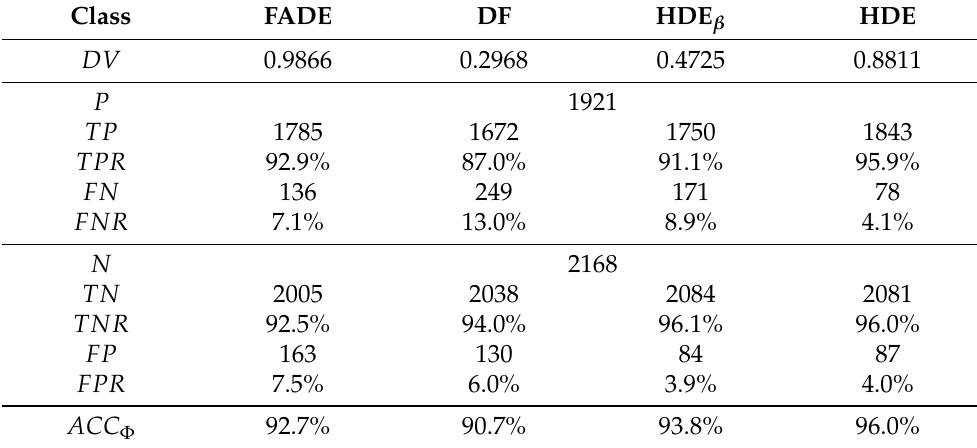
Table 5. The updated accuracy report for hazy/haze-free image classification task using haze density